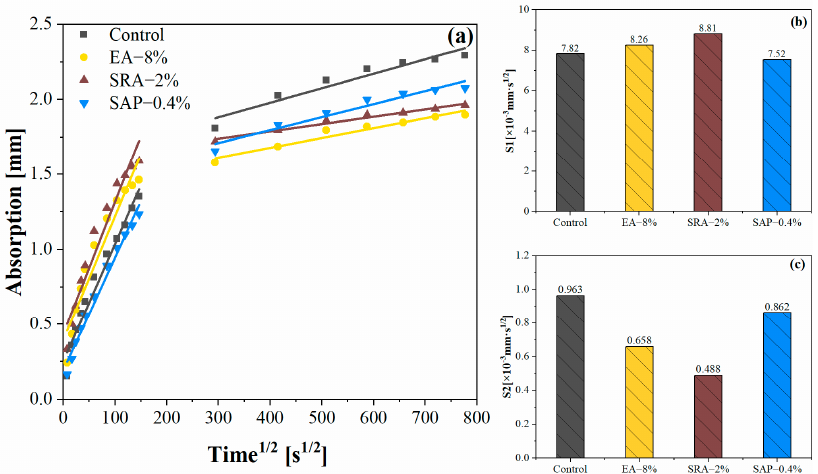
Figure 10. The different shrinkage-reducing components on the 28 d capillary water absorption of concrete: ( a ) total water uptake; ( b ) slope of S1 adsorption phase; ( c ) slope of S2 adsorption phase.